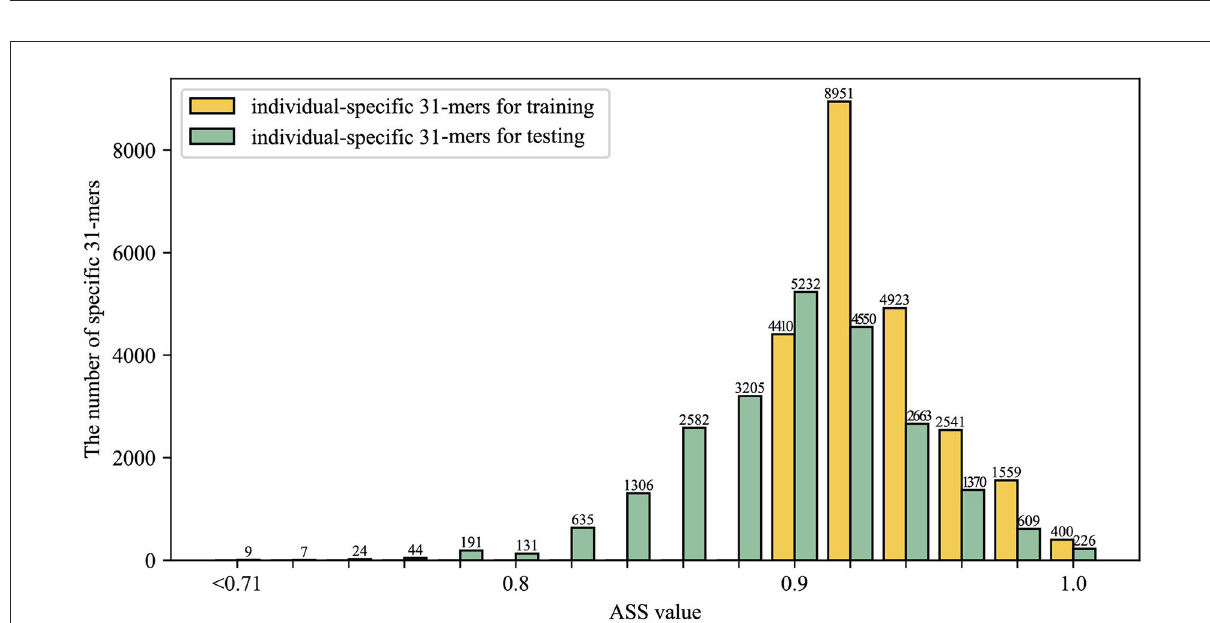
FIGURE6 Evaluation of body site stability of identified individual-specific k -mers, showing specific k -mers identified by ASS value of HV08 individual-specific 31-mers on two groups samples. Yellow bars and green bars represent individual-specific 31-mers on training and testing, respectively. The number above the bar chart represents the number of individual-specific 31-mers included in that ASS